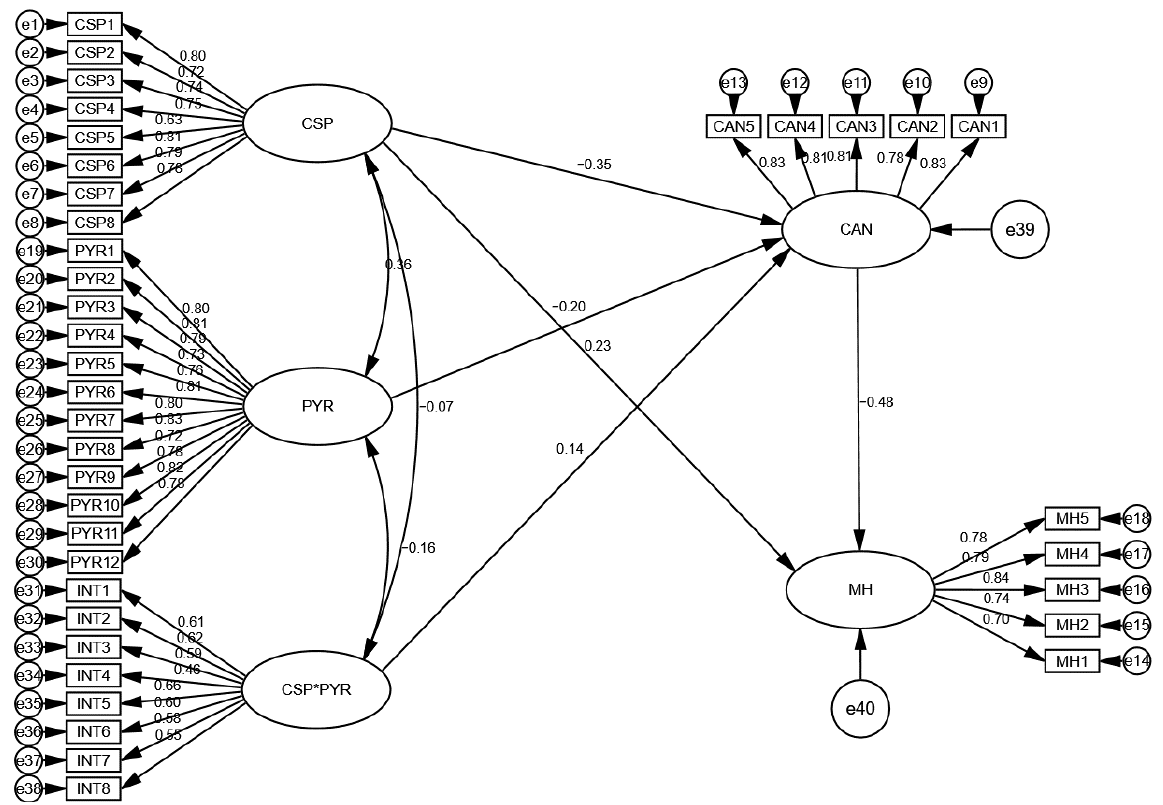
Figure 3. Structural equation model.